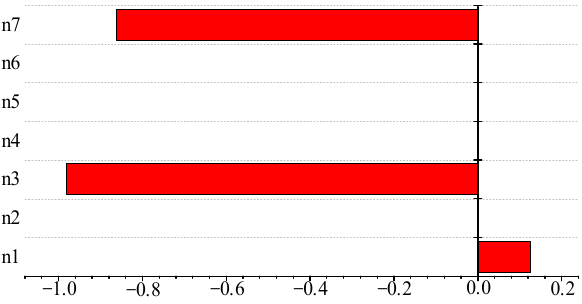
Figure 25. Correlation of 7 optimization parameters to maximum deformation sensitivity.